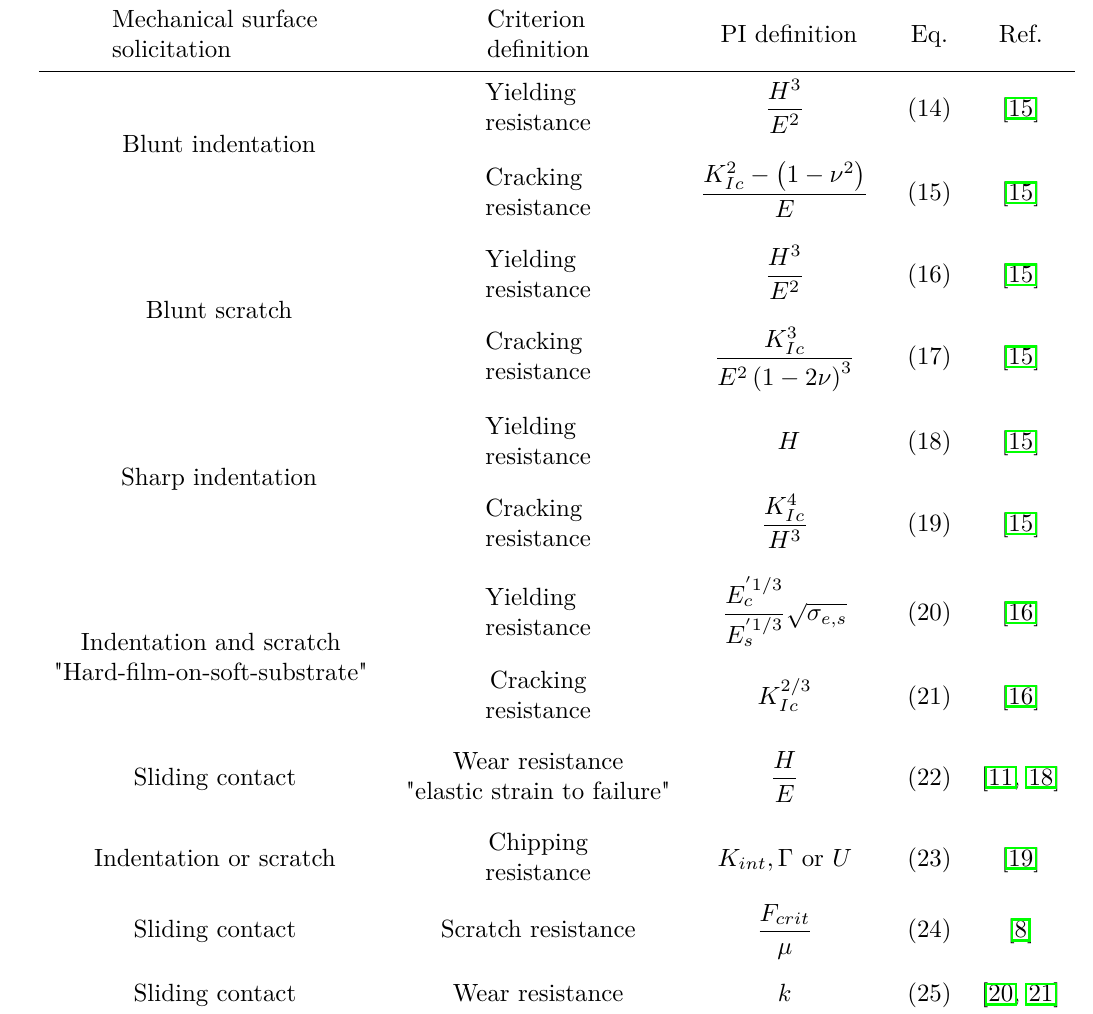
Table 2. Non-exhaustive list of performance indices for coating system